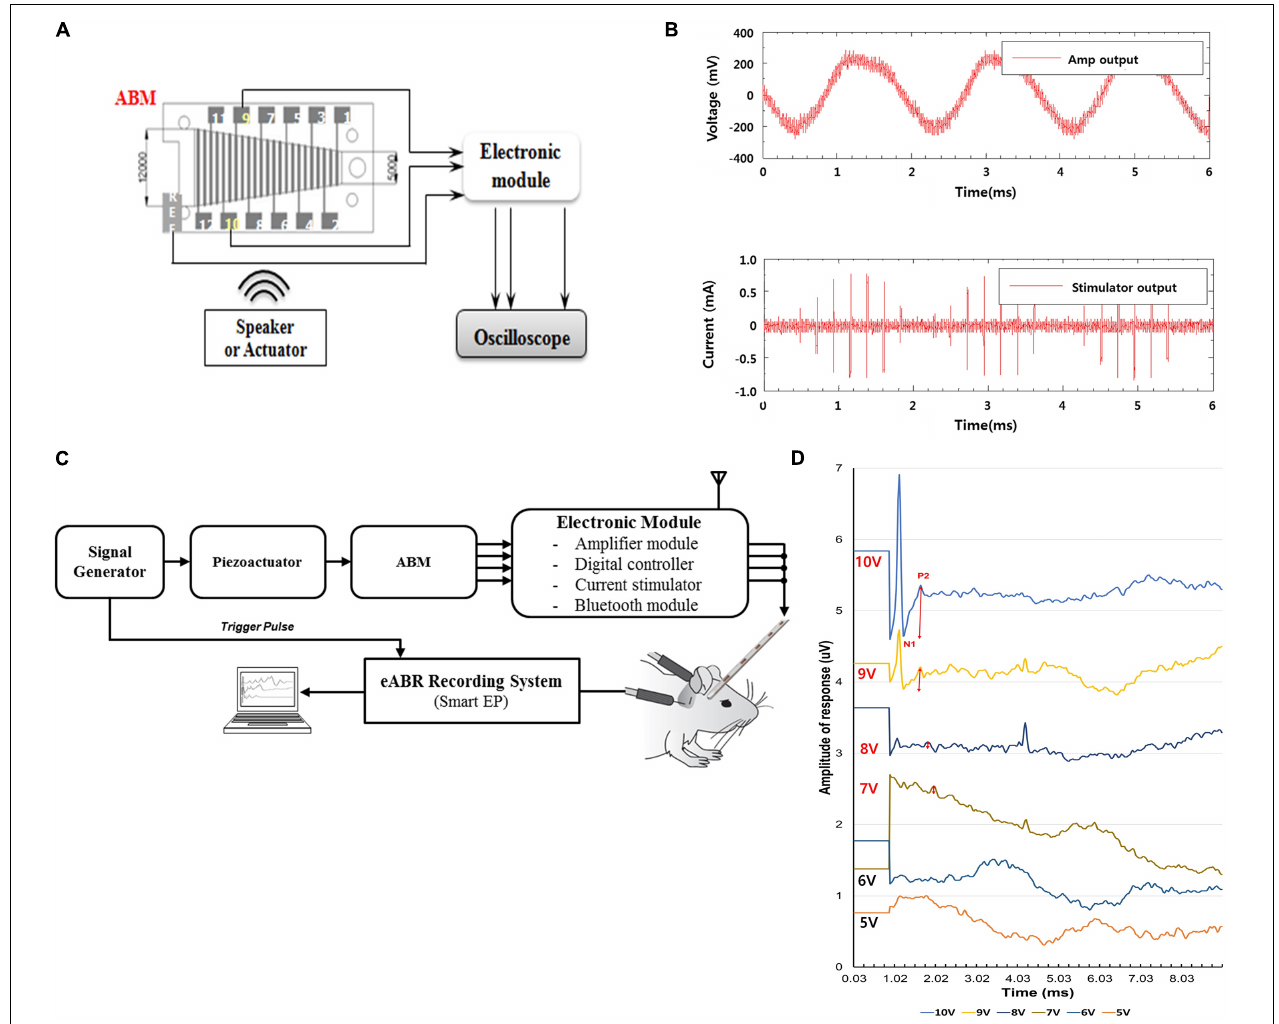
FIGURE 4 | Evaluation of Output Pulse and eABR recordings after Connection between the ABM and the Electronic Module ( in vivo and in vitro ). (A) Measurement setup of output pulse in ABM puls EM ( in vitro ). (B) The graph of output pulse in ABM plus EM ( in vitro ). (C) The experimental setup measuring the eABR in a subject. (D) Auditory brainstem responses of deafened guinea pigs stimulated by amplified output of electricity generated by the ABM in response to piezoactuator. The red two-way arrow indicates the N1-P2 wave. The N1-P2 wave gradually increased in amplitude as the intensity of the stimulus increased from